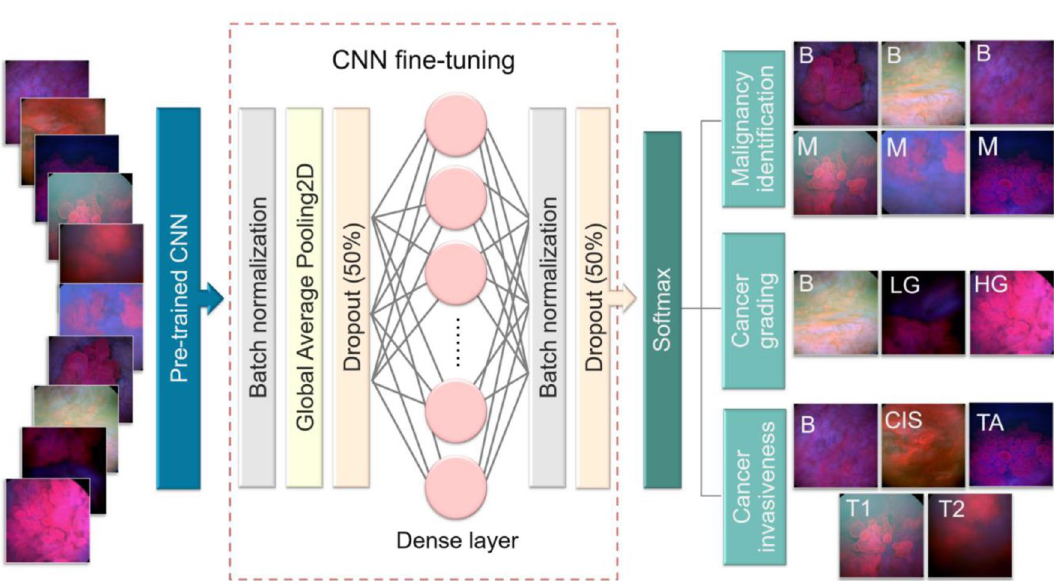
Figure 6. Schematic diagram of the CNN fine-tuning considered for identifying bladder cancer. Each pre- trained CNN was fine-tuned by appending two batch normalization layers, a global average pooling layer, dropout layers with the probability of 50%, a dense layer to improve cancer identification, and Softmax activation layer. The last layer delivers different label probabilities for each input image with respect to each classification